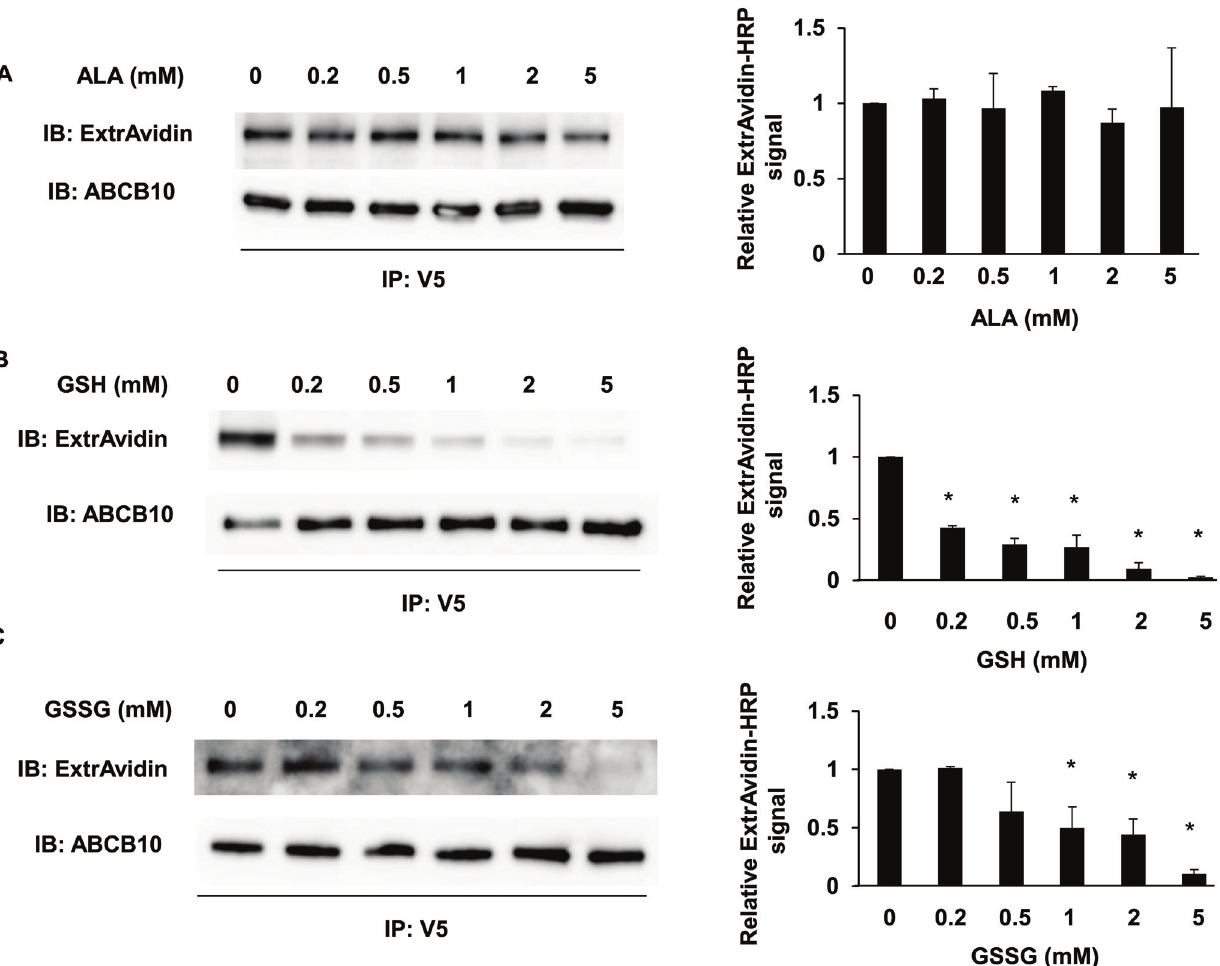
Fig 5. d-Amino-levulinic acid (d-ALA) does not alter 8-azido-ATP-[ γ ]-biotin photolabeling in ABCB10, whereas GSH and GSSG do. A) Increasing concentrations of delta-aminolevulinic acid (d-ALA) did not change the photolabeling of ABCB10 by 8-azido-ATP [ γ ] biotin. Representative Western blot analyses are shown. The bar graph shows the relative intensity of ExtrAvidin-HRP as mean ± SD of independent experiments. B) and C) Increasing concentrations of GSH or GSSG decreased the biotin signal during the photolabeling of ABCB10 by 8-azido-ATP [ γ ] biotin. The bar graph shows the relative ExtrAvidin-HRP signal. Three independent experiments were conducted and data are shown as mean ± SEM. * p < 0.05 vs. signal in 0mM GSH or GSSG